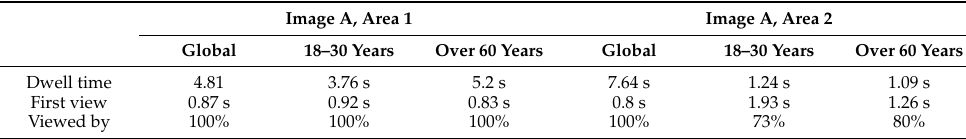
Table 5. Age segments analysis. Image A.